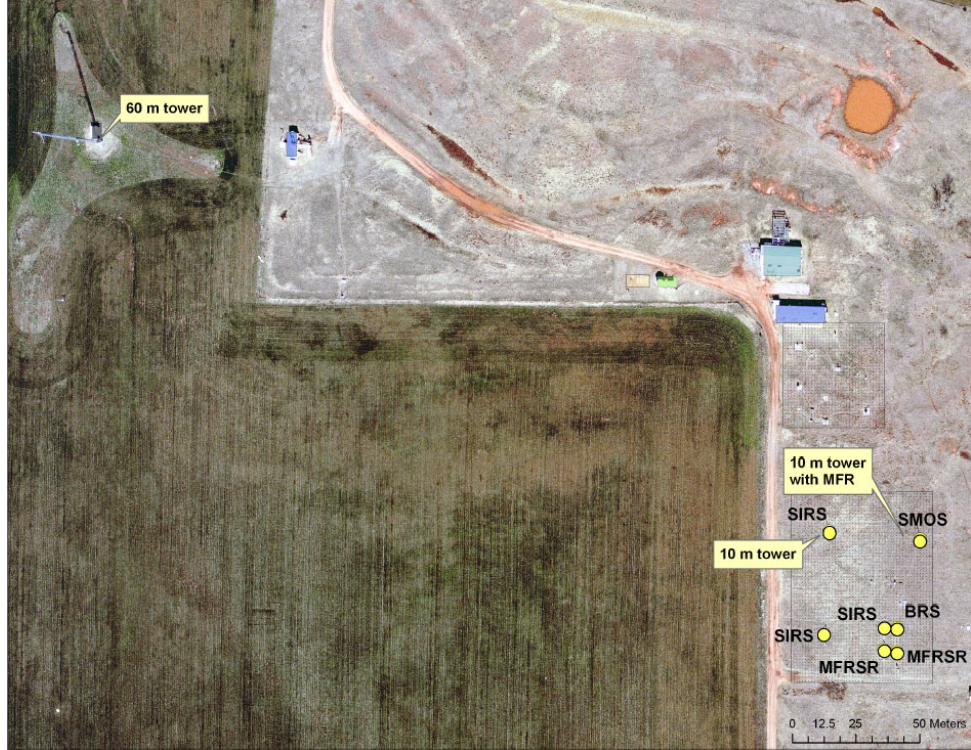
Fig. 1. Map of SGP central facility indicating the location of the radiometers used in this study. Photo courtesy of Aerial Oklahoma, Inc. Map annotations provided by Alice Cialella, Brookhaven National